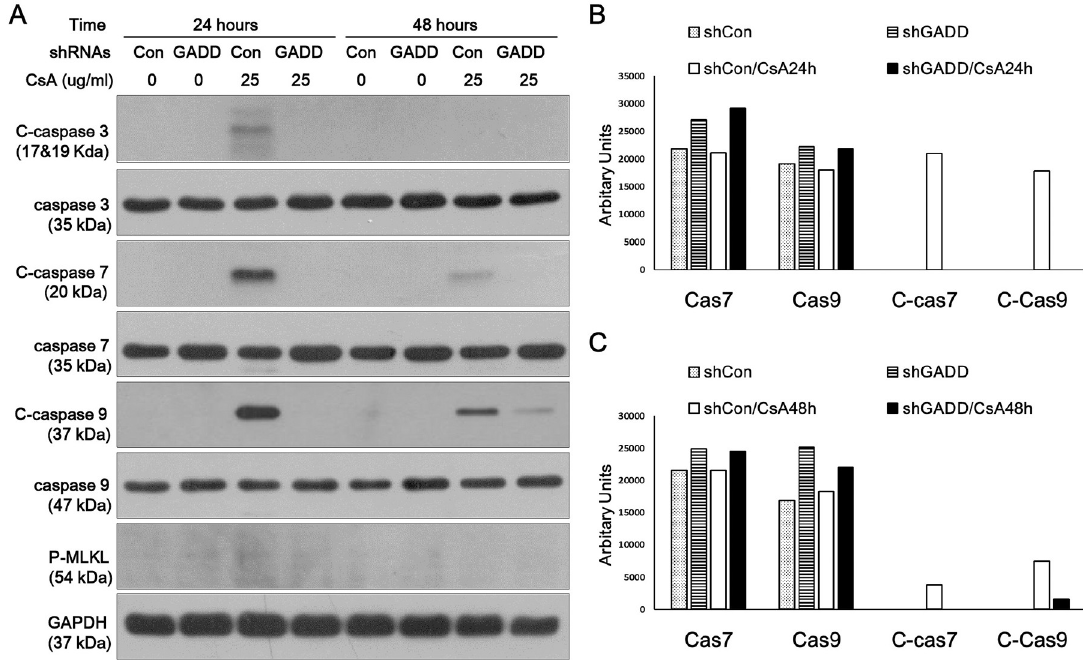
Fig 11. Western blot analysis of caspase activation in HRE cells: Effect of silencing of GADD45G. shGADD and shCon HRE stable cells were incubated with 25 μ g/ml CSA for 24 and 48 hours to harvest protein for western blotting. (A) . Quantification of western blots (caspase 7, caspase 9, C-caspase 7, C-caspase 9) was performed using Image J at 24 hours (B) , and 48 hours of incubation with CsA (C) . C-caspases represent cleaved (active)-caspases; shRNA GADD, shRNA constructs to knockdown GADD45G; shRNA Con, control shRNA constructs targeting no known